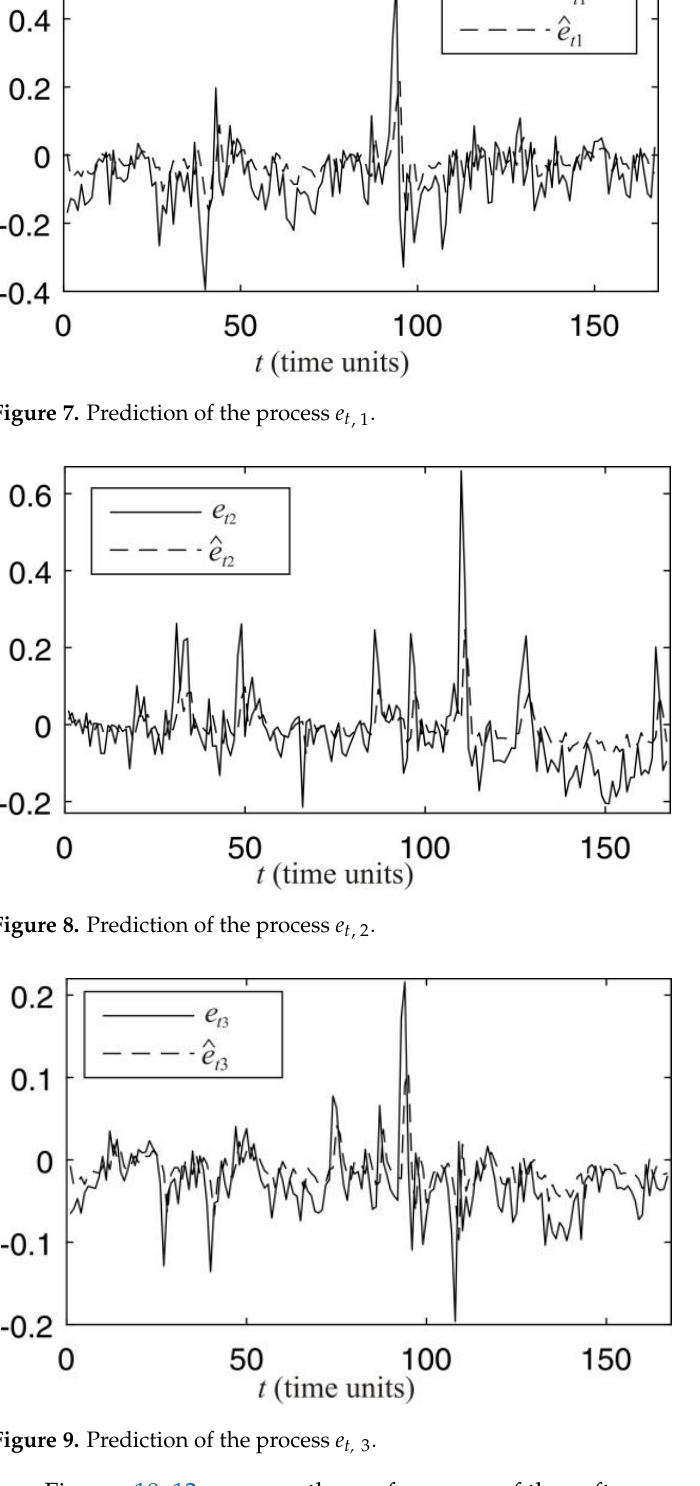
Figure 9. Prediction of the process e t, 3.